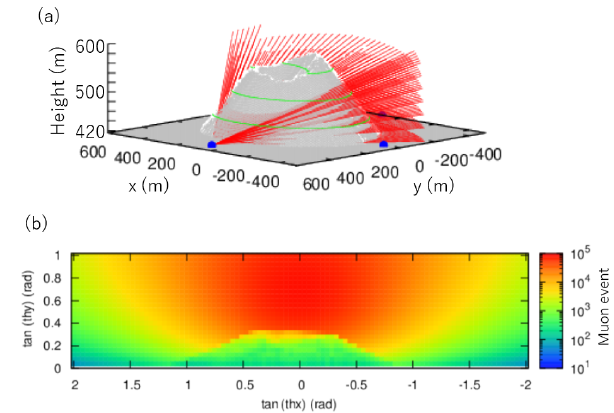
Figure 4. An example of theoretical muon count simulation: (a) the observation state at observation point A; (b) the theoretical muon count observation at that